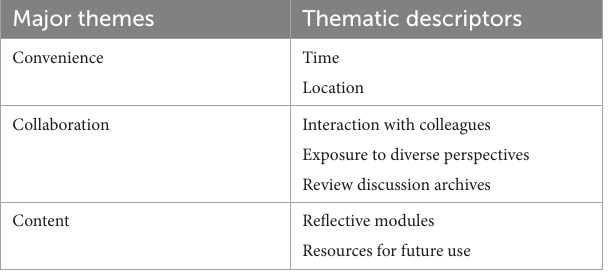
TABLE 3 School leaders’ qualitative questionnaire